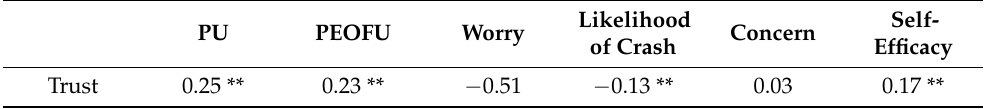
Likelihood Self- Concern of Crash Efficacy